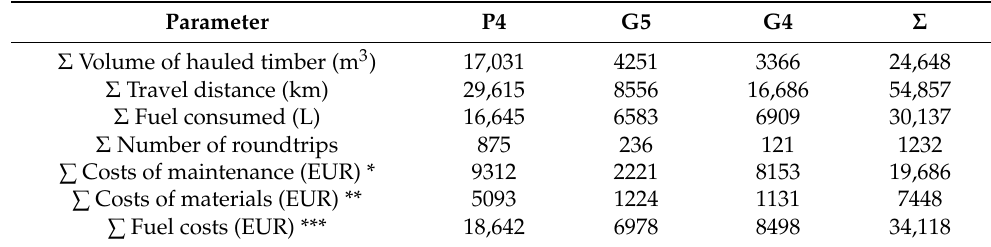
Table 2. Summary of selected timber haulage parameters for the Scania P450 (P4), G500 (G5), and G440 (G4) logging